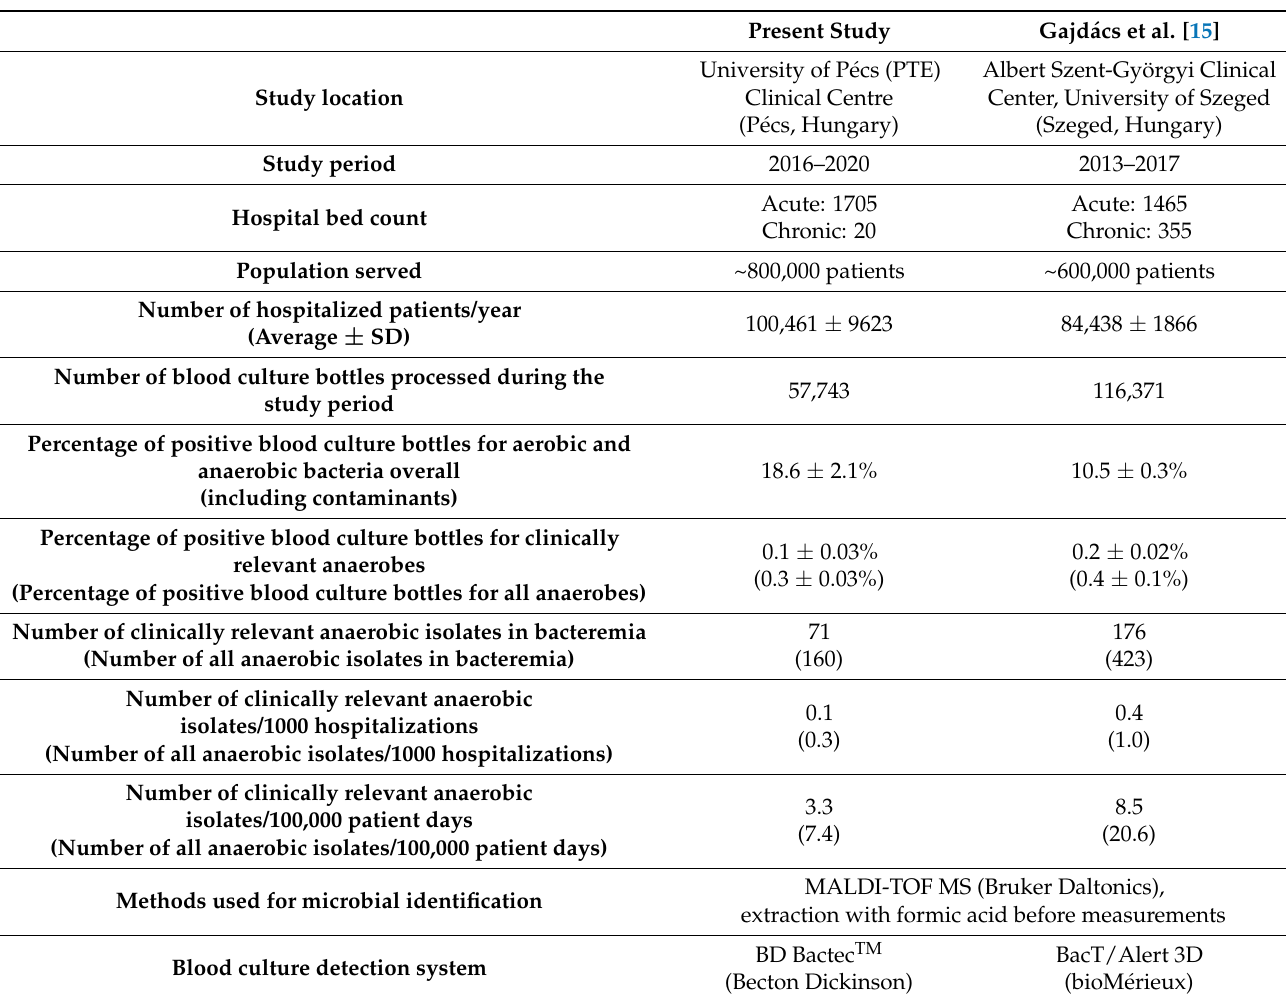
Table 1. Comparison of study settings and primary results of the present study with our previous comparator